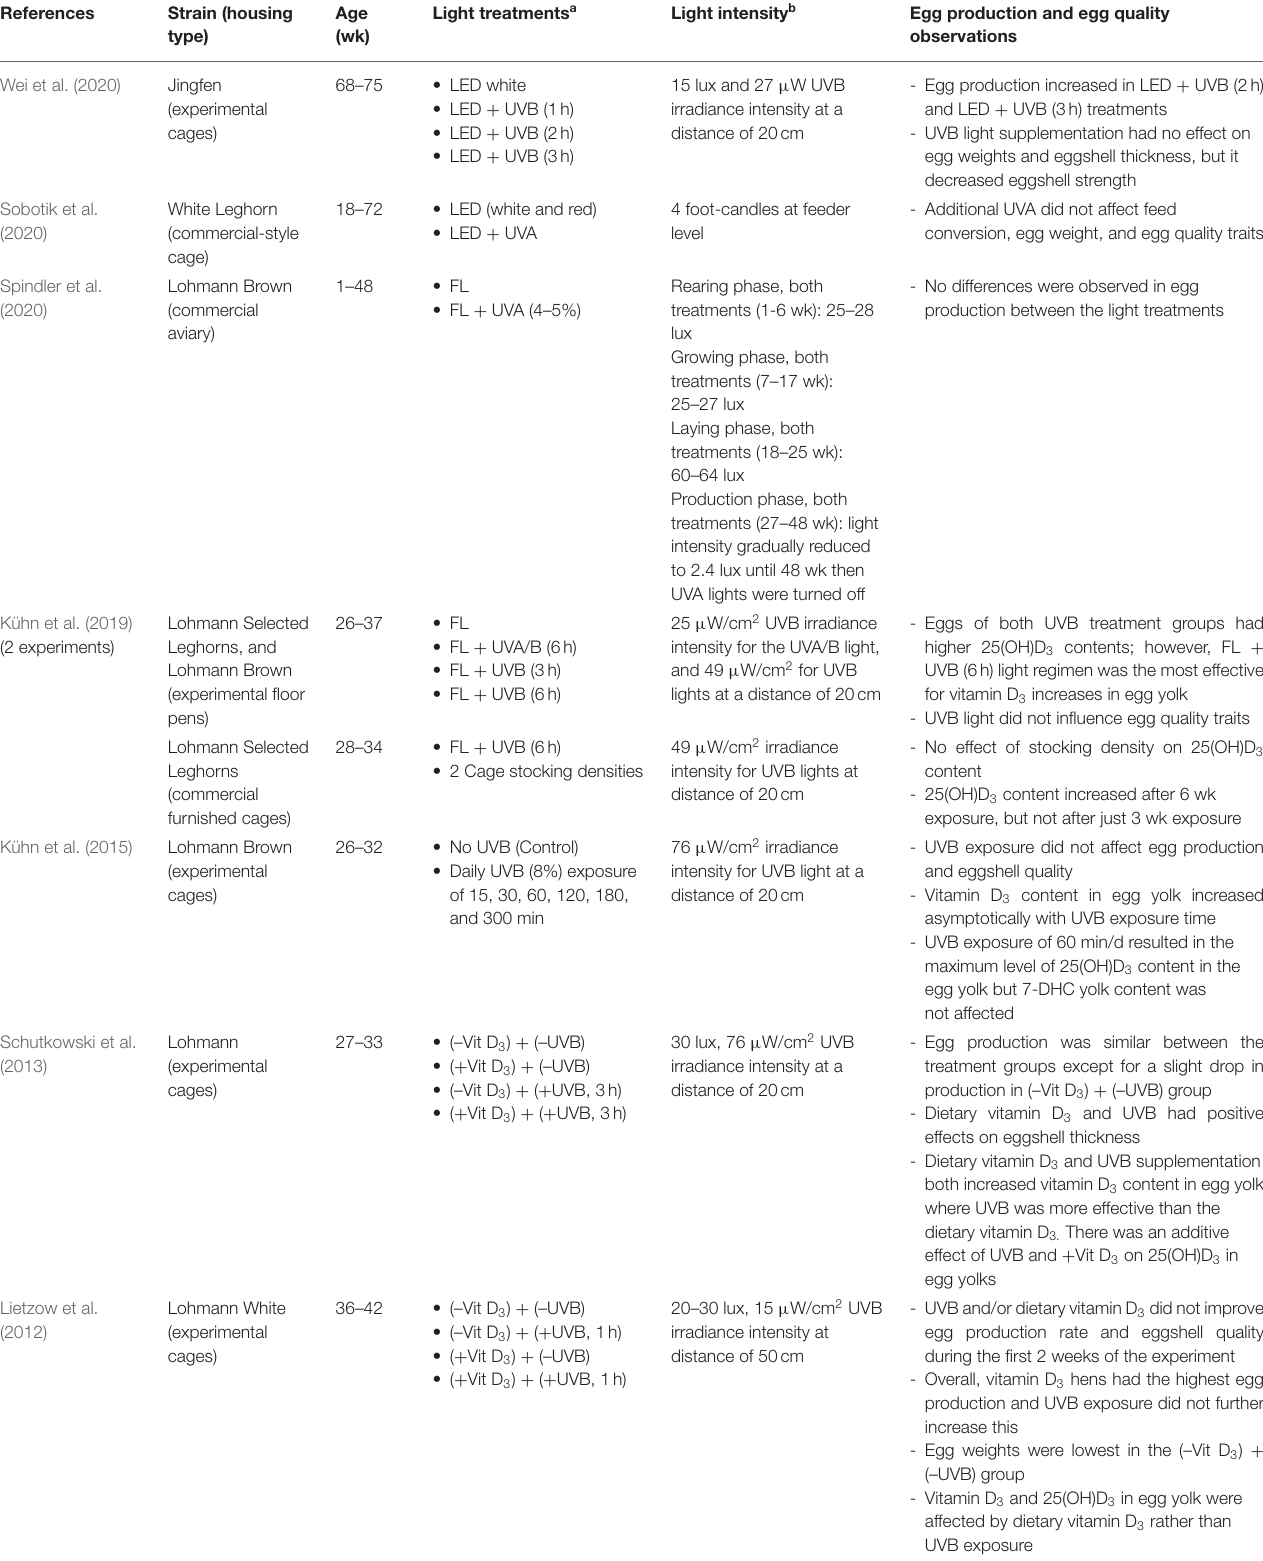
TABLE 3 | Effects of UV light on egg production and egg